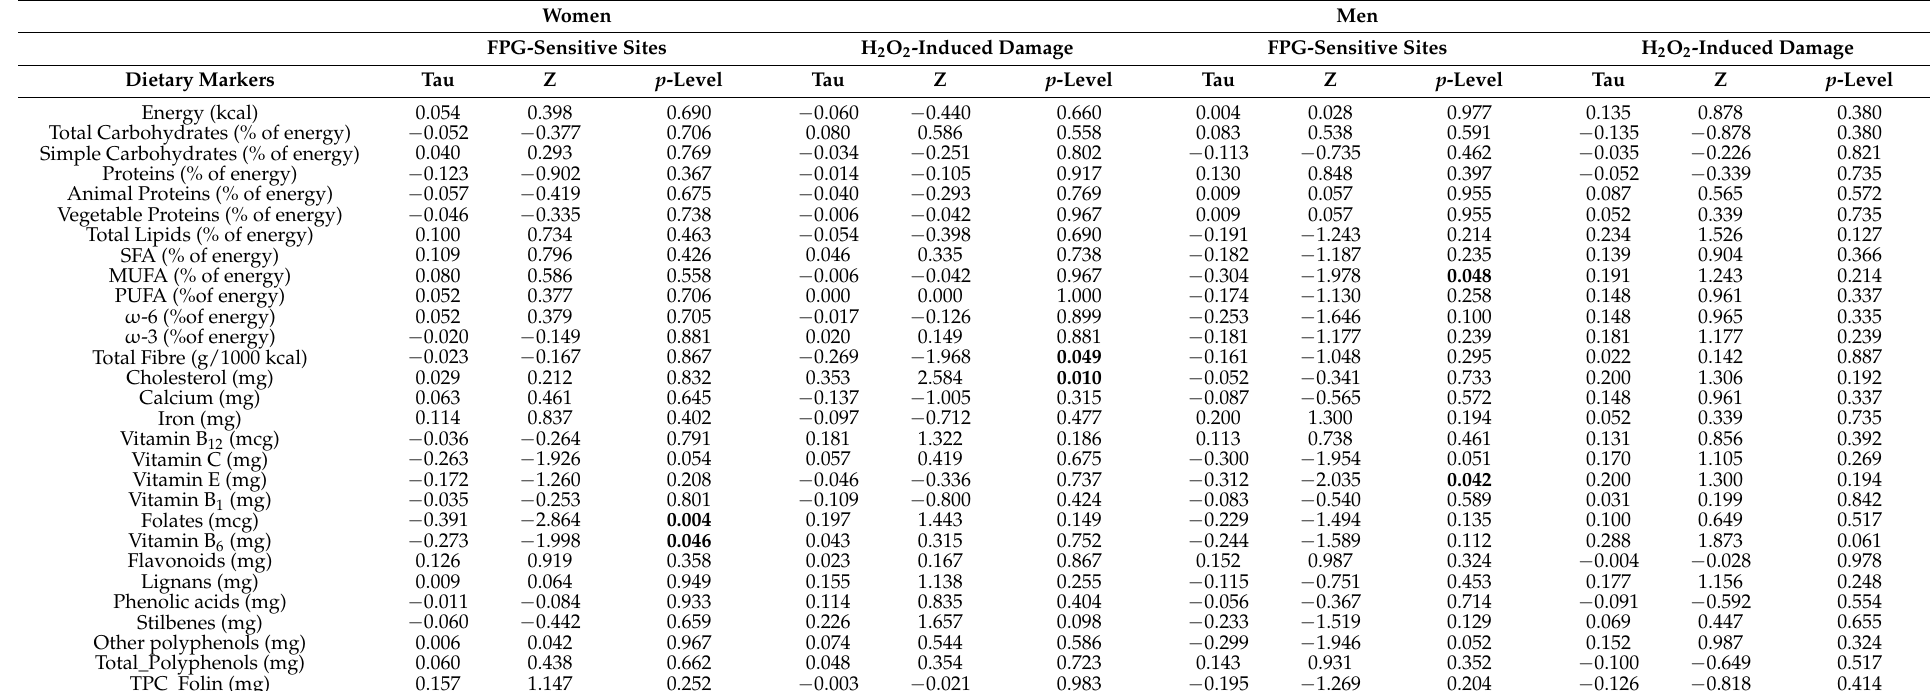
Table 3. Correlation analysis between dietary markers and DNA damage in women and